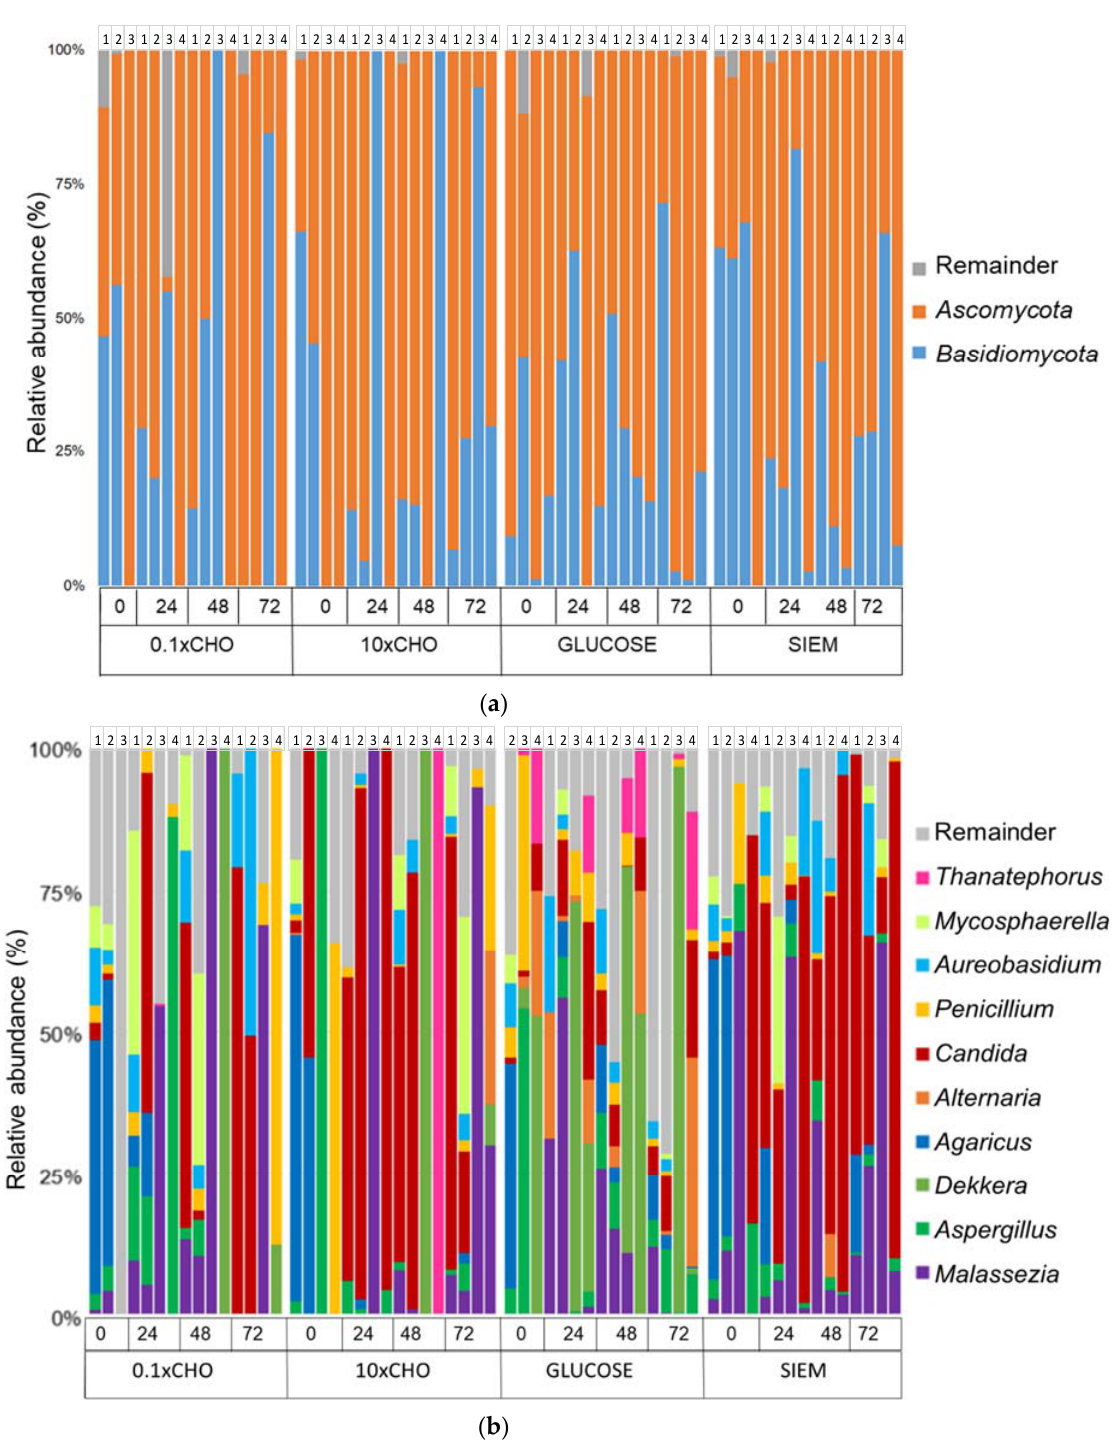
Figure 7. Relative abundance (%) of major groups of fungi during the intervention period after inoculation in TIM ‐ 2; ( a ) phyla; ( b ) genera.